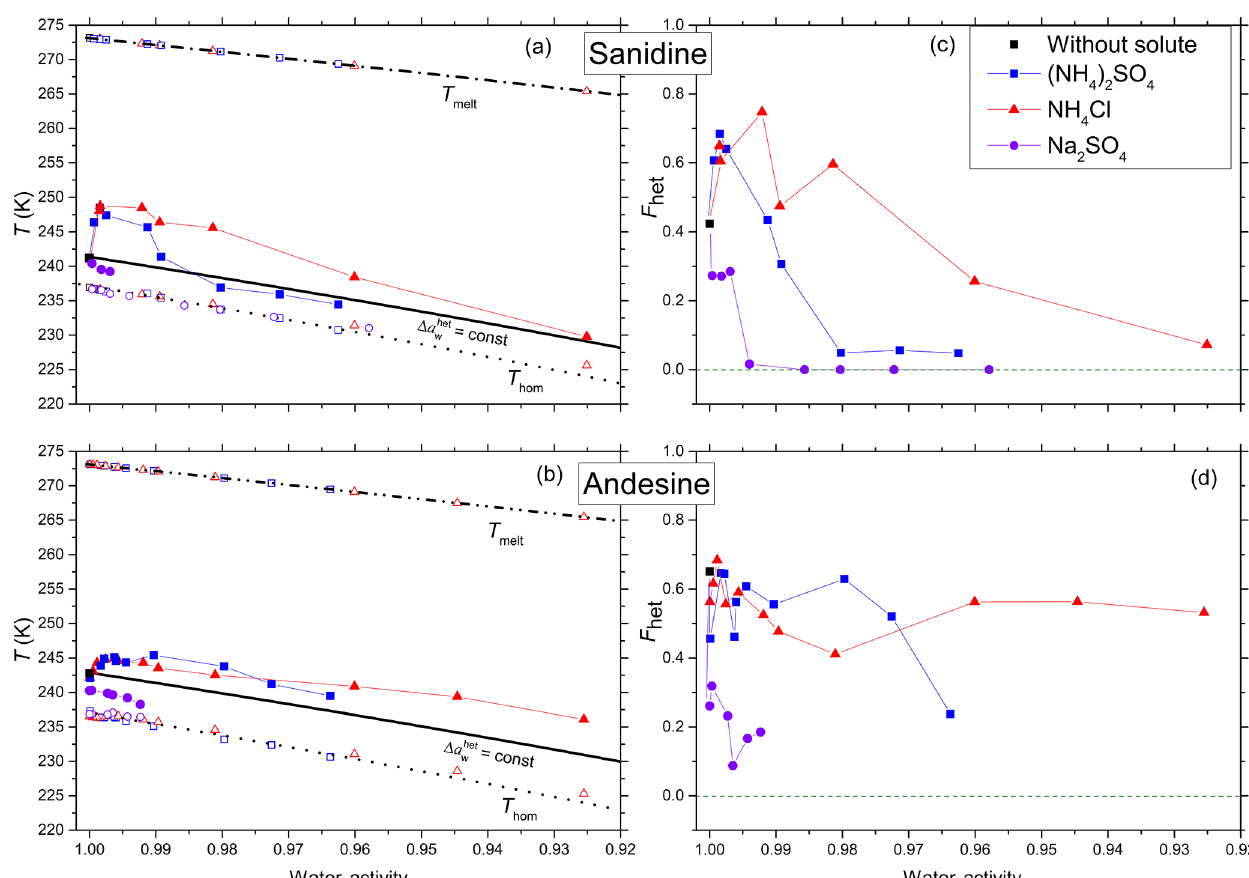
Figure 2. Measured freezing temperatures (a, b) and heterogeneously frozen fractions (c, d) of emulsion freezing experiments with 2wt% feldspar, namely sanidine (a, c) and andesine (b, d) , in various solutions (color coded). (a, b) Heterogeneous freezing onset temperatures, T het (filled solid symbols connected by thin lines to guide the eye); homogeneous freezing onset temperatures, T hom (open symbols at T < 237K); and ice melting temperatures, T melt (open symbols at T > 265K) as functions of water activity of solutions, a w , for various solutes (symbols and colors see insert). Dash-dotted black line: ice melting point curve. Dotted black line: homogeneous ice freezing curve for supercooled aqueous solutions obtained by horizontally shifting the ice melting curve by a constant offset (cid:49)a hom w (T ) = 0 . 294. Solid black line: horizontally shifted from the ice melting curve by (cid:49)a het w (T ) = 0 . 264 and 0.254 for sanidine (a) and andesine (b) , respectively, with offsets derived from the heterogeneous freezing temperature of the suspension of the mineral in pure water (filled black square at a w = 1). Symbols are the mean of at least two separate emulsion freezing experiments. Difference between the two measurements plus instrumental uncertainty in T het and a w are smaller than the symbol size (see Sect. 2.2). (c, d) Heterogeneously frozen fraction, F het , as a function of a w , for sanidine (c) and andesine (d) . Measurement difference and uncertainty in F het do not exceed ±